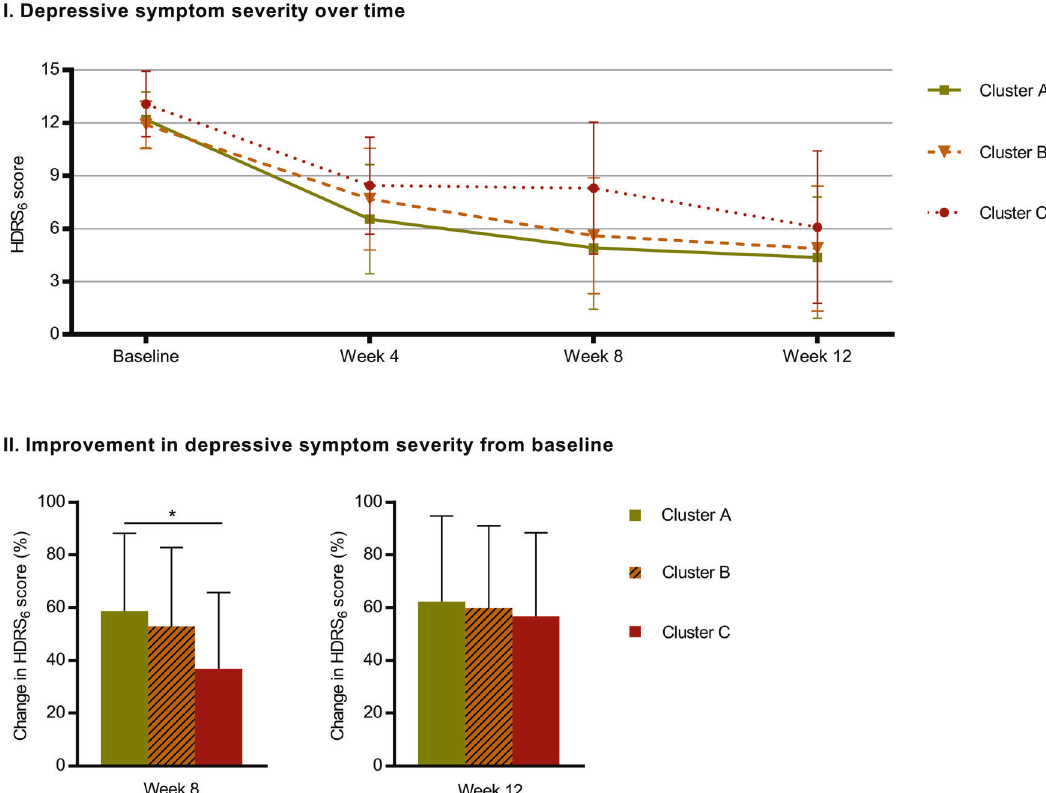
Fig. 1 Change in depressive symptom severity over time for cognitive pro fi le clusters. Panel I shows Hamilton Depressive Rating Scale 6 (HDRS 6 ) scores for each of the three cognitive pro fi le clusters at baseline, week 4, week 8, and week 12. Panel II shows improvement (i.e., reduction) in HDRS 6 scores in percentage for the three cognitive pro fi le clusters at week 8 and week 12 relative to baseline. The graphs show observed group averages and the error bars denote standard deviations while the signi fi cance notation in panel II represents model estimates corrected for age and sex. * p <